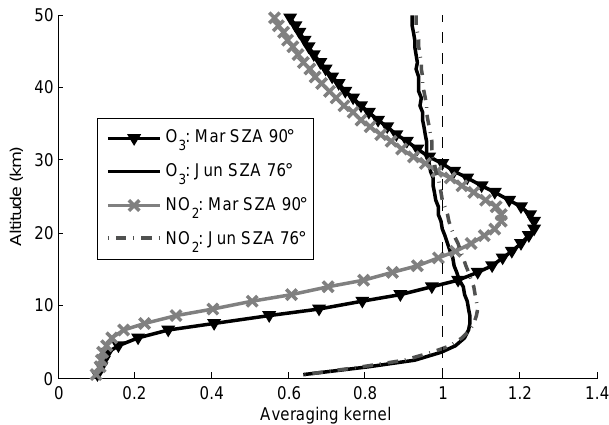
Fig. 1. Approximate column averaging kernels for DOAS measure- ments of ozone and NO 2 in March at SZA 90 ◦ and June at SZA 76 ◦ . For ozone, the Hendrick et al. (2011) AMF LUTs were used and for NO 2 , the AMF LUTs described in Appendix A were used. Note that for NO 2 , measurements do not extend below 17km, as AMFs are set to zero below